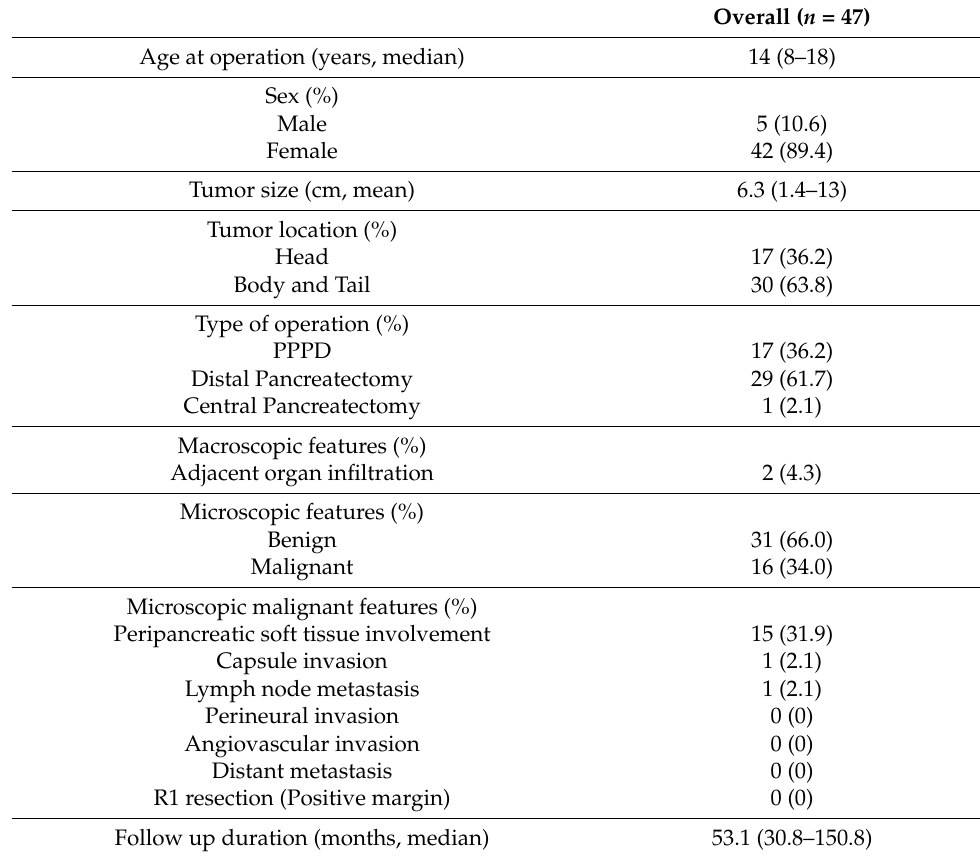
Table 1. Demographic characteristic of the patients.